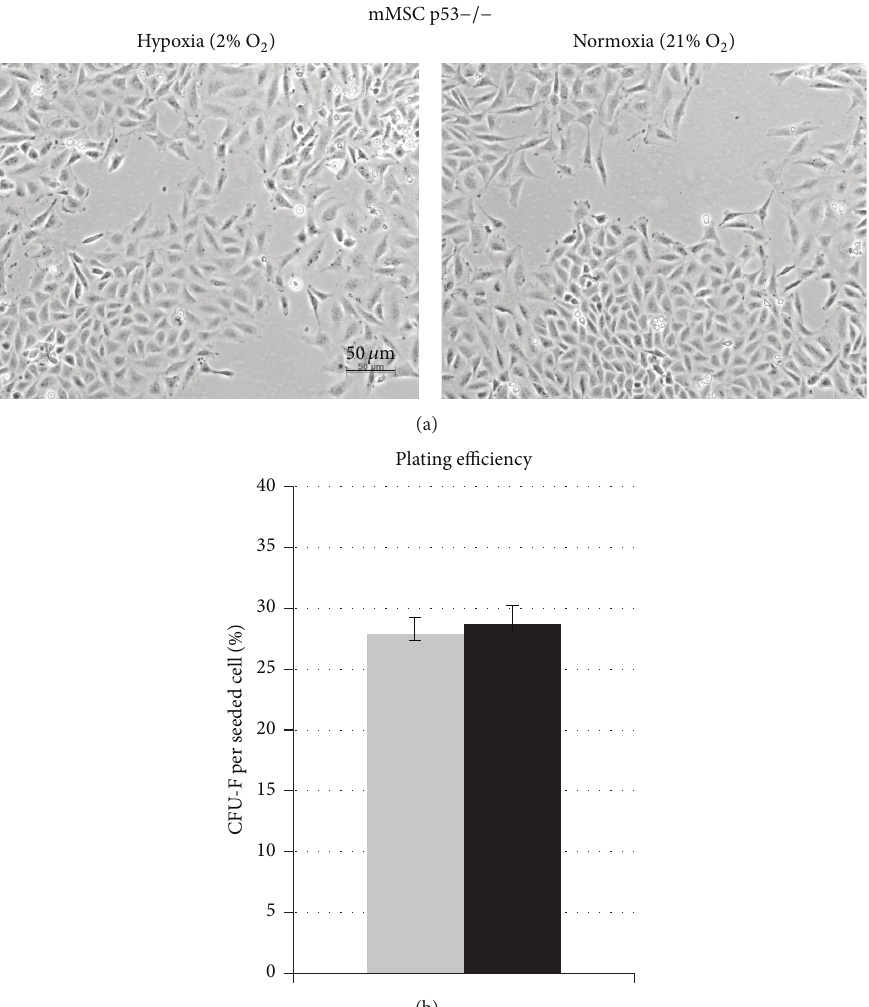
Figure 5: Impact of p53 status on oxygen effect of long-term in vitro culturing and colony formation capacity of mMSCs. (a) Morphology of mMSCs p53 − / − cultured in hypoxic conditions (left image) and in normoxic conditions (right image). Representative images show mMSCs p53 − / − cultured for 20 days. (b) Colony forming ability of mMSCs p53 − / − after 14 days in hypoxic (grey bar) and normoxic (black bar) cultures calculated as mean values of fibroblast colony-forming units (CFU-F) per plated cell (3 biological